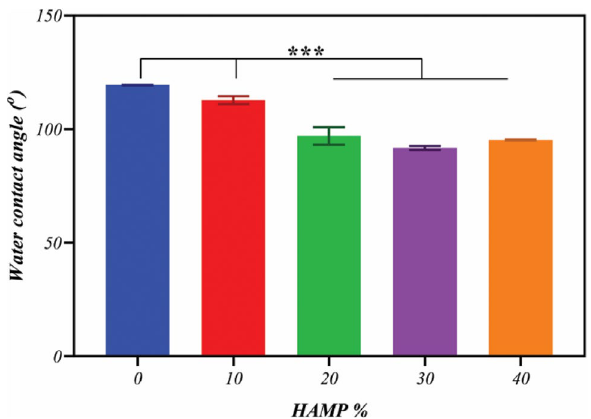
Figure 10. The water contact angle of fibrous scaffolds with different amounts of HAMP.